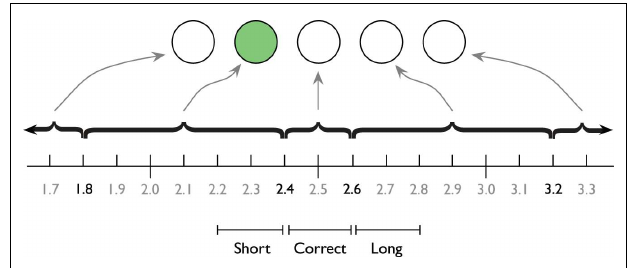
FIGURE 1 |The horizontal row of five circles depict an example feedback screen. The green circle indicates the participant that the produced interval was too short.The time line indicates the ranges associated with particular feedback circles.The three pseudo-experimental conditions as defined by Macar et al. (1999) on which the ANOVA analyses are based are illustrated below the timeline.